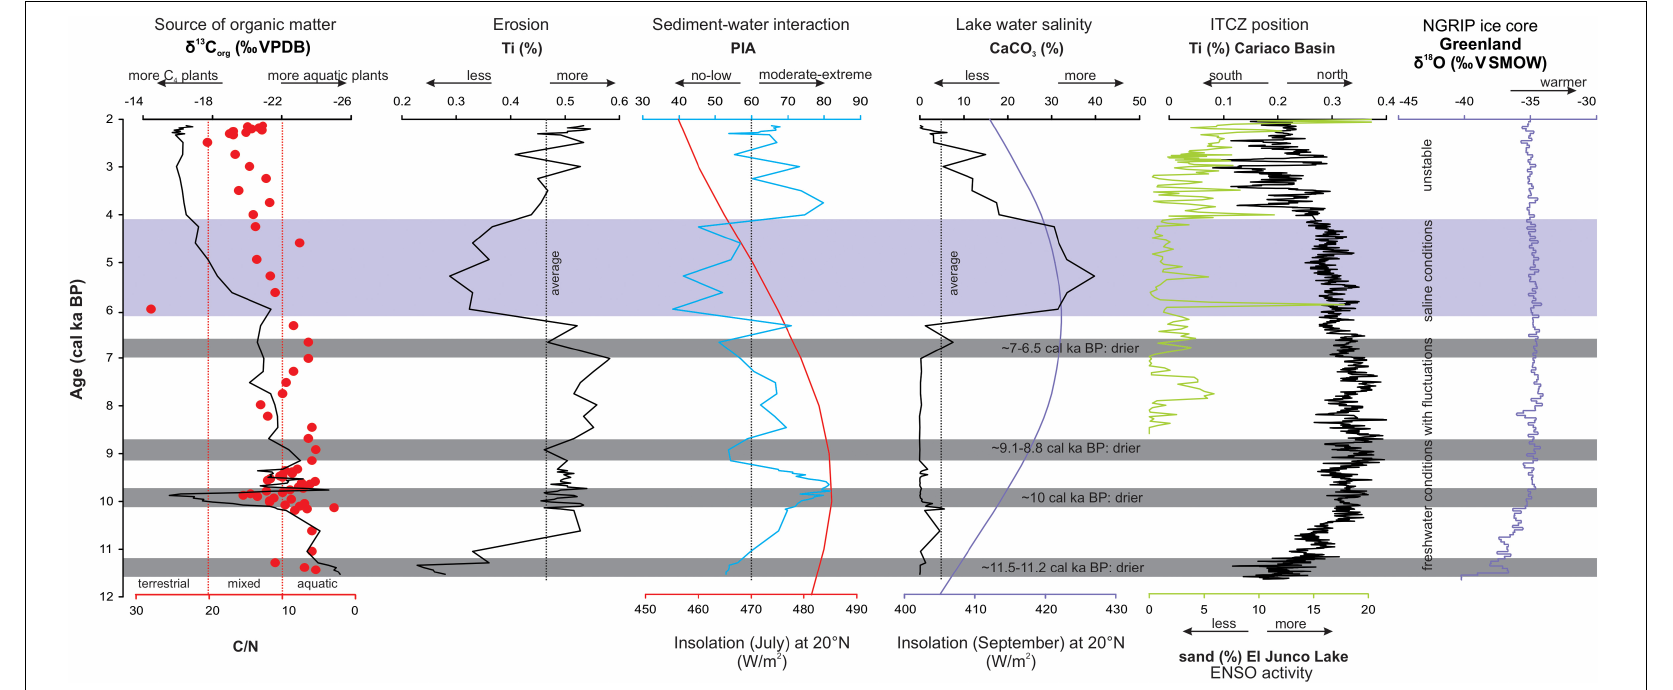
FIGURE 8 | Proxy records showing source of organic carbon (C/N and δ 13 C org ), erosion (Ti), sediment-water interaction in watershed (PIA), and water column salinity (CaCO 3 ) compared with the summer (July) and autumn (September) insolation (Berger and Loutre, 1991), mean position of ITCZ (Haug et al., 2001), ENSO activity (Conroy et al., 2008) and North Hemisphere temperature (NGRIP Project Members, 2004) both in orbital and